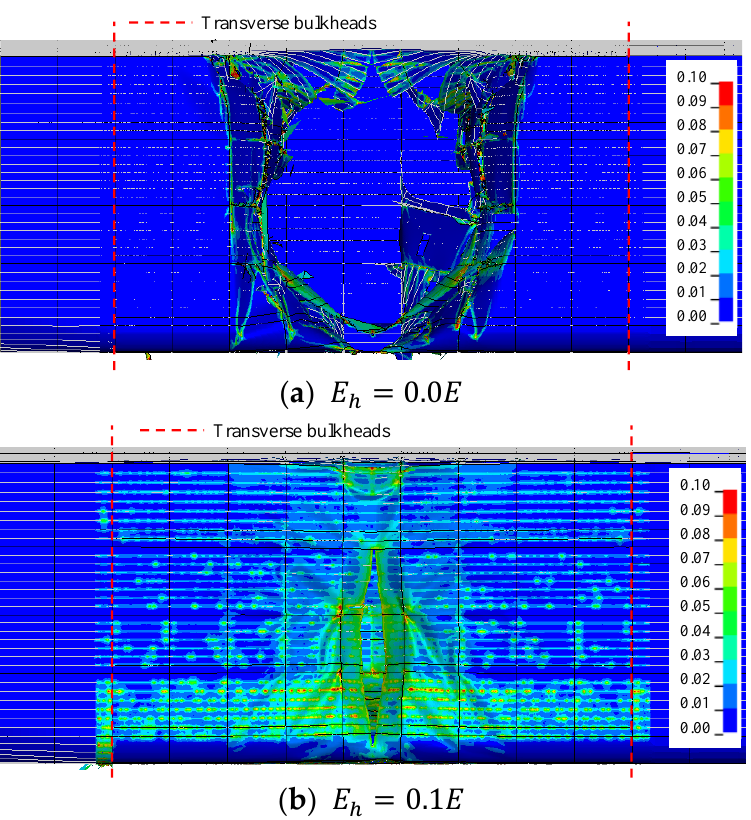
Figure 10. The effect of hardening moduli on the plastic strain distribution (0.1 of DFS and 5 knots of 𝑉 𝑜 ).